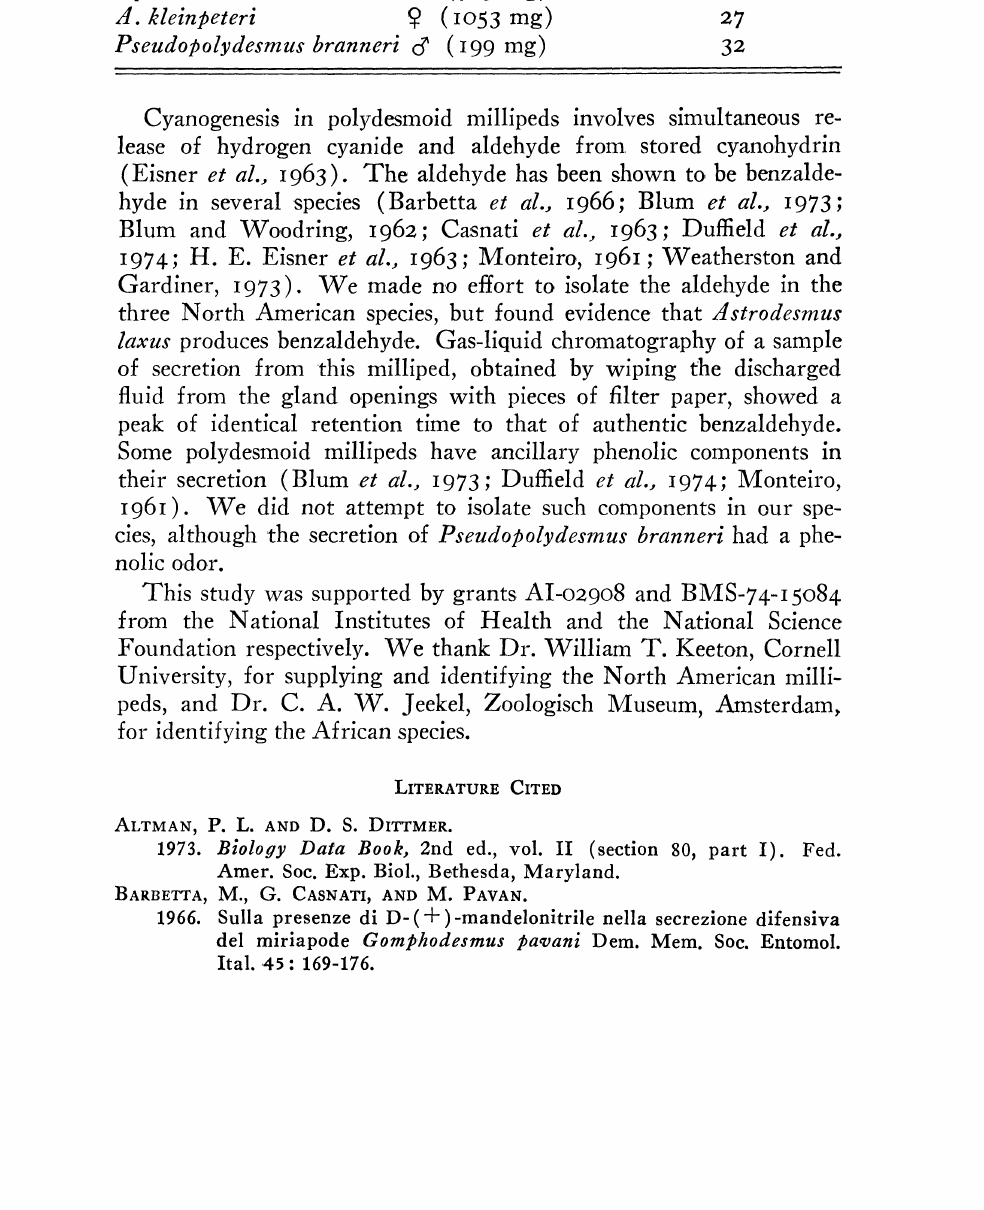
CYANOGENETIC OUTPUT OF MILLIPEDS Species Sex and Body Weight o.f